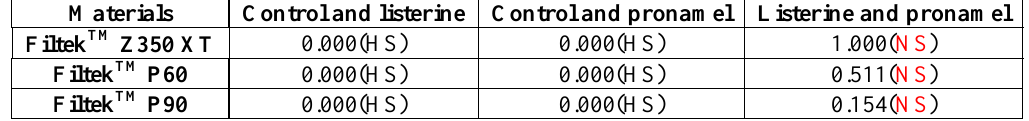
Table 4: LSD test between subgroups of the tested solution against each type of composite